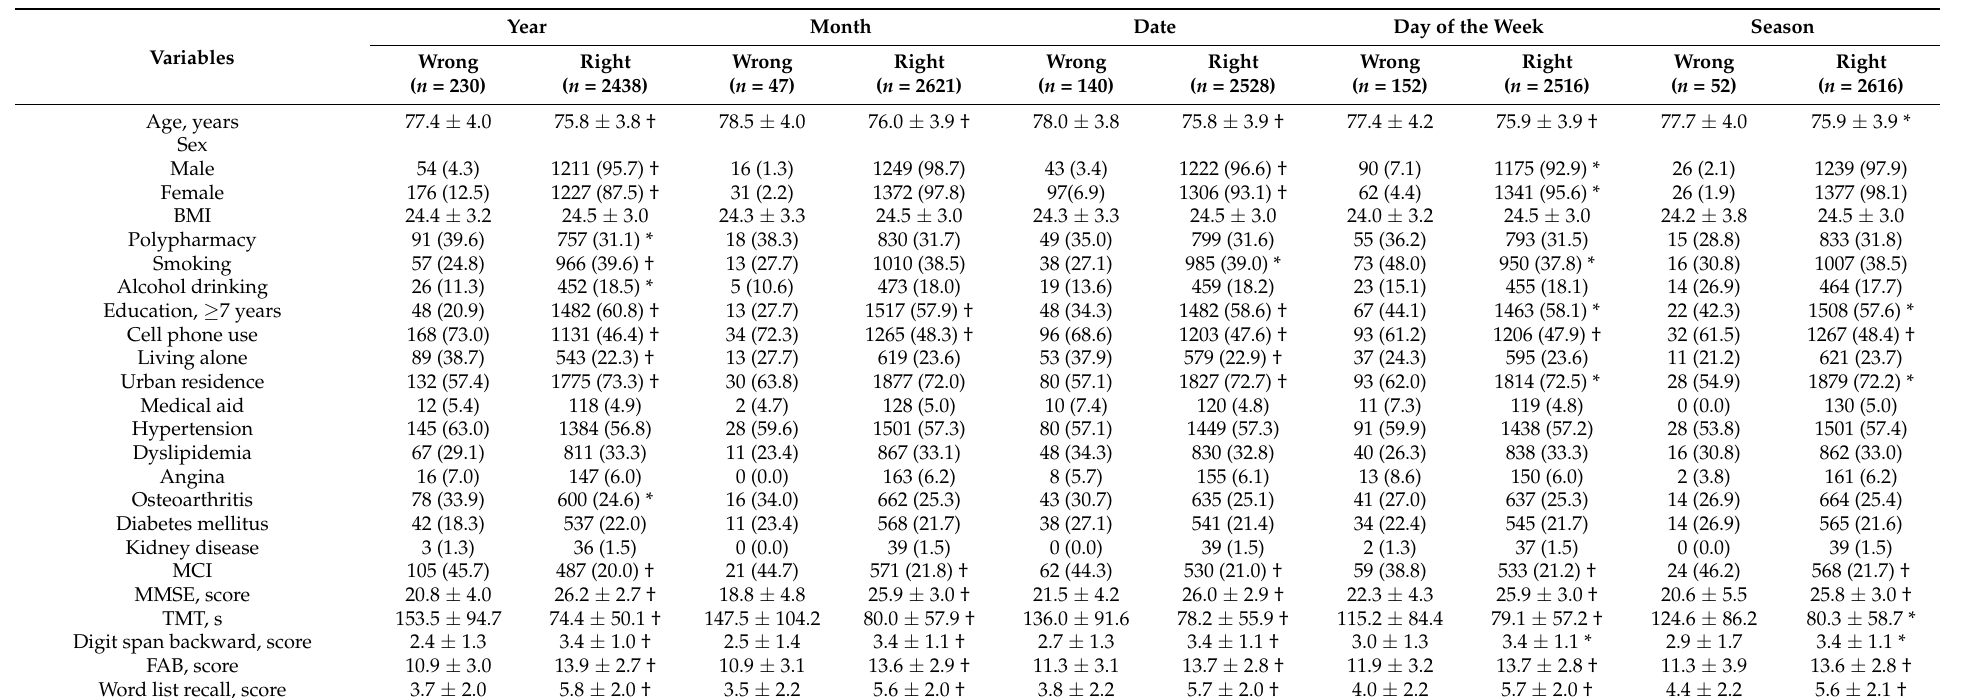
Table 2. Baseline characteristics of study participants according to each time orientation.